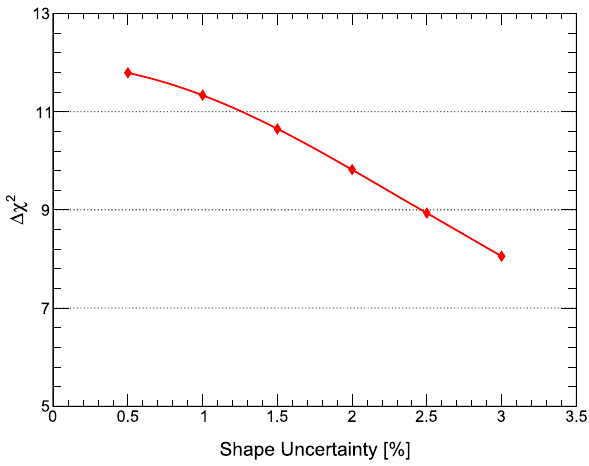
Fig. 11 MH discrimination sensitivity for different near detector uncertainties. The energy resolution of ND is fixed to be 3%